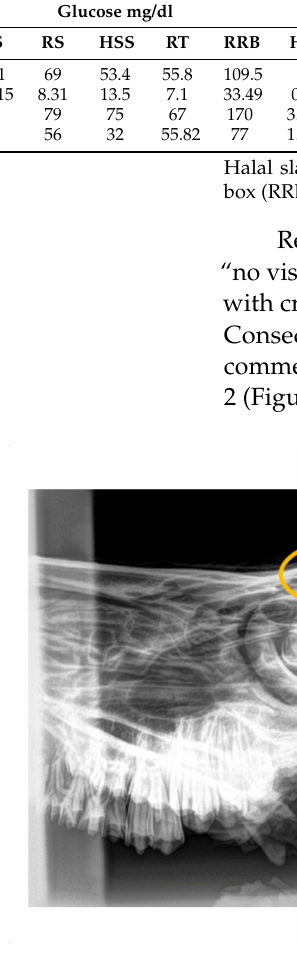
Figure 3. Digital radiography rating 1 (following Malaysia Standard 1500:2009), and related photograph.